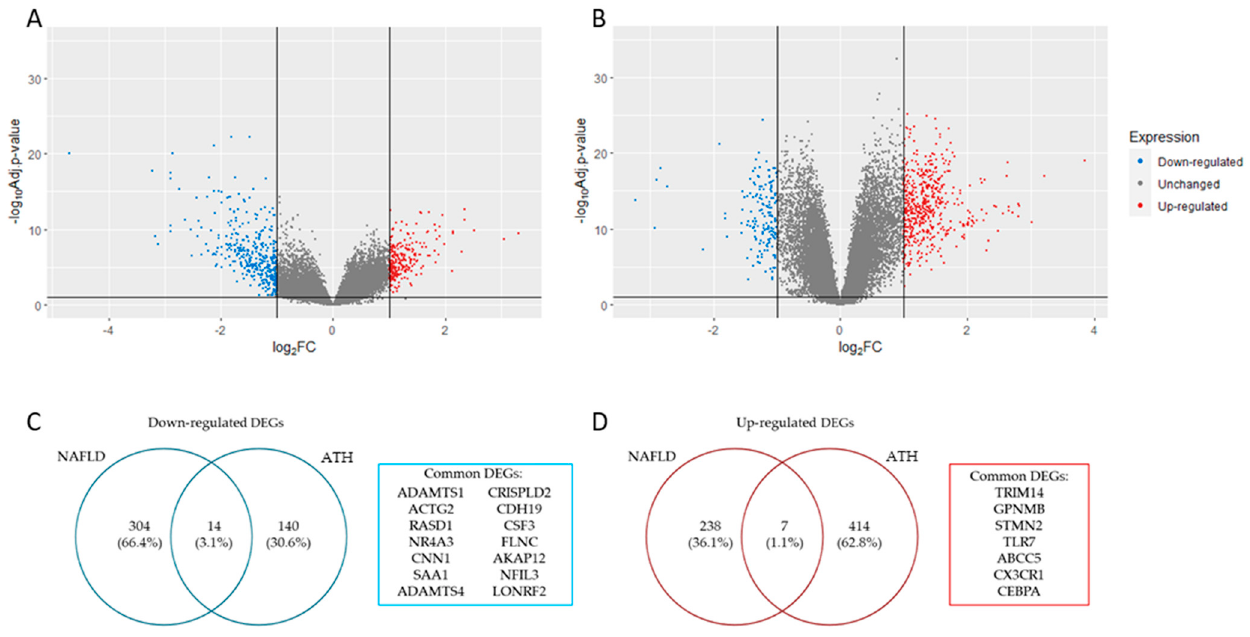
Figure 1. Panels ( A , B ) show volcano plot with DEGs identified in NAFLD and ATH, respectively (|log2 FC (fold change)|>1 and adj. p -value < 0.05). Panels ( C , D ) show a list with common down- (|log2 FC (fold change)|> 1 and adj. p -value < 0.05). Panels ( C , D ) show a list with common down- and up-regulated DEGs identified in both pathologies, and up-regulated DEGs identified in both pathologies, respectively.